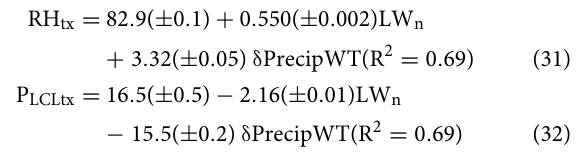
Frontiers in Earth Science |